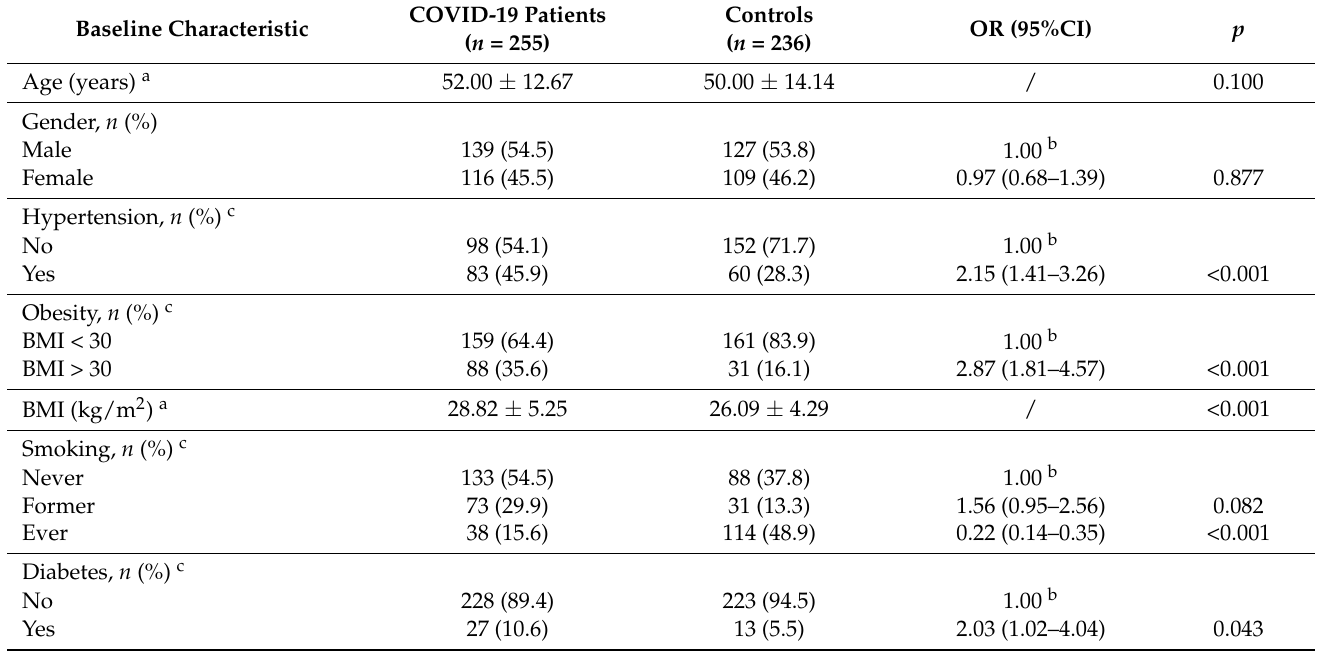
Table 1. Baseline characteristic of COVID-19 patients and respective